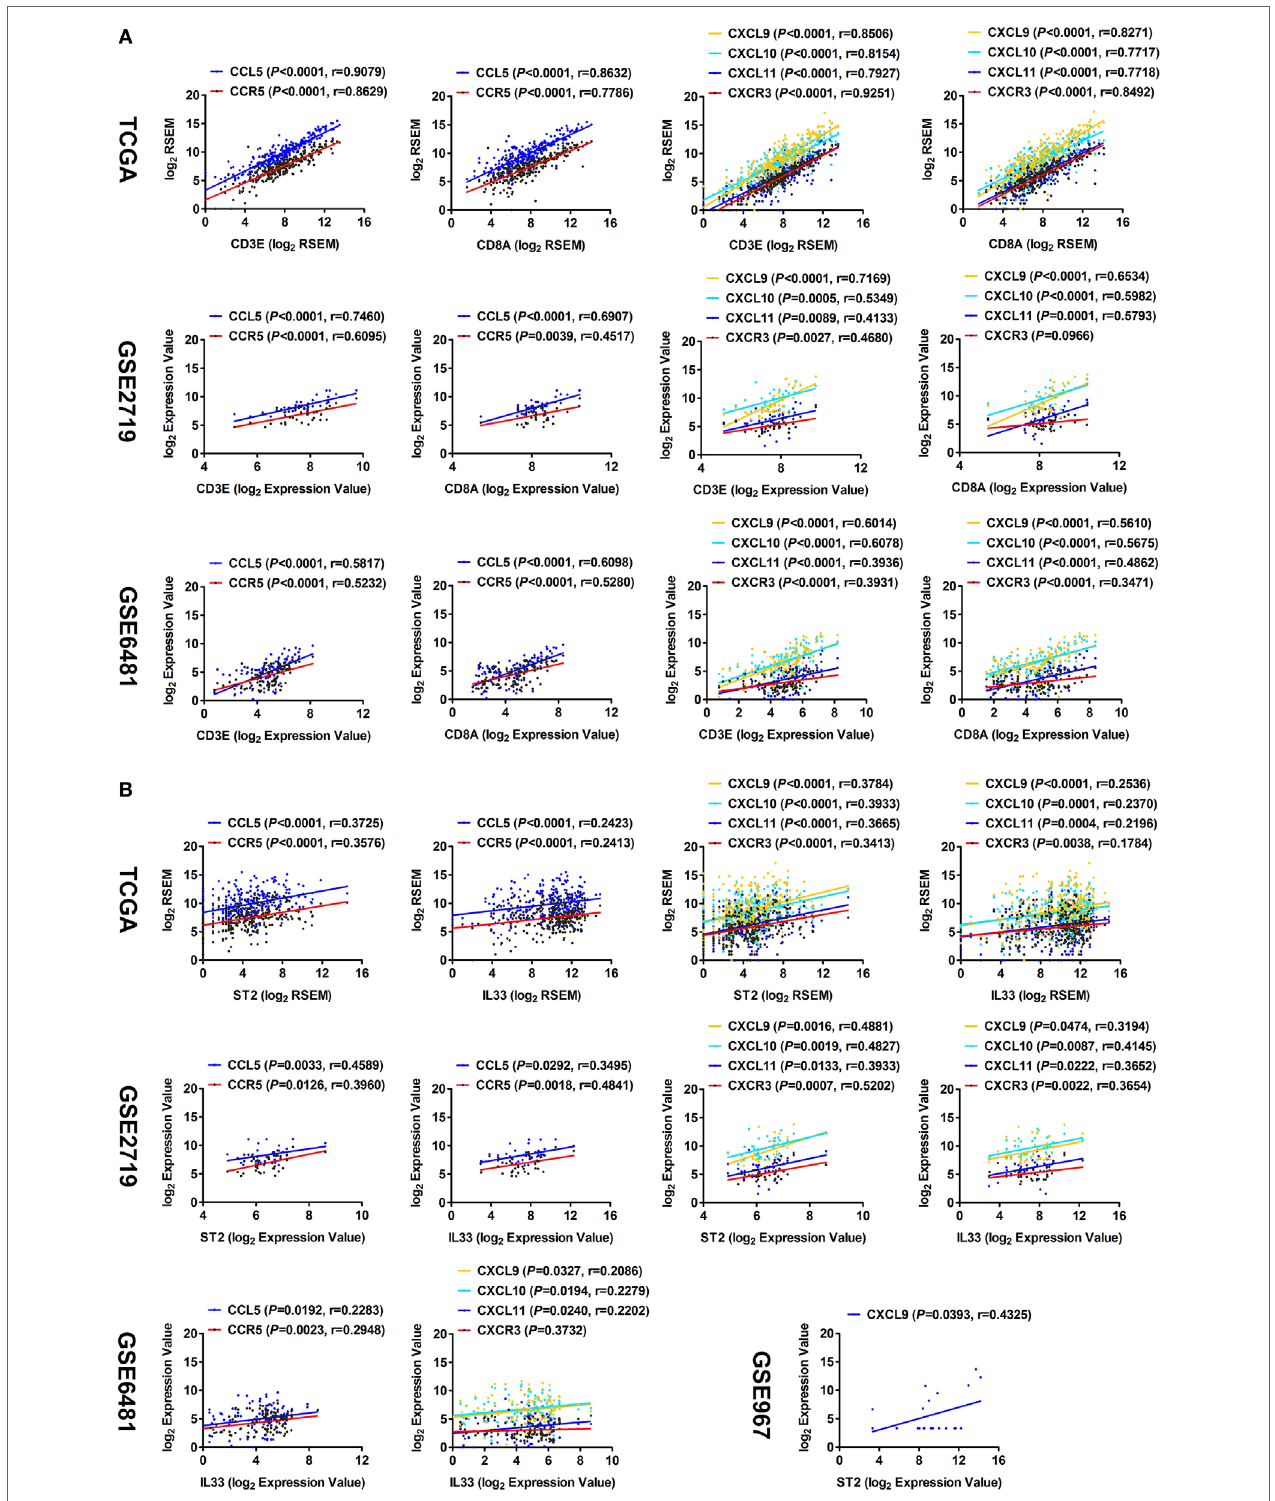
FigUre 4 | Correlation between the expression of ST2/IL-33 and chemokines that recruit CD8 + T cells in soft tissue sarcoma. (a) Positive correlations between the transcriptional levels of CD3E/CD8A and CCL5 and its receptor CCR5, and between CD3E/CD8A and CXCL9/10/11 and their receptor CXCR3 by analyzing sarcoma data of The Cancer Genome Atlas (TCGA), GSE2719, and GSE6481 (sample number = 105). (B) Positive correlations between the transcriptional levels of ST2/IL-33 and CCL5 and its receptor CCR5, and between ST2/IL-33 and CXCL9/10/11 and their receptor CXCR3 by analyzing sarcoma data of TCGA, GSE2719, GSE6481, and GSE967. The correlation between gene expression levels was analyzed by Pearson correlation test.